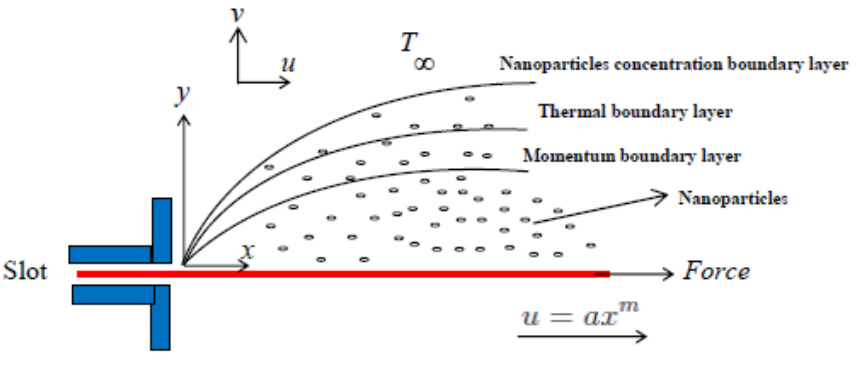
Figure 1. Sketch of flow